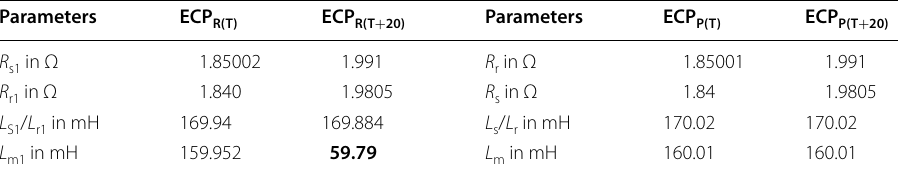
evaluation using ECP m